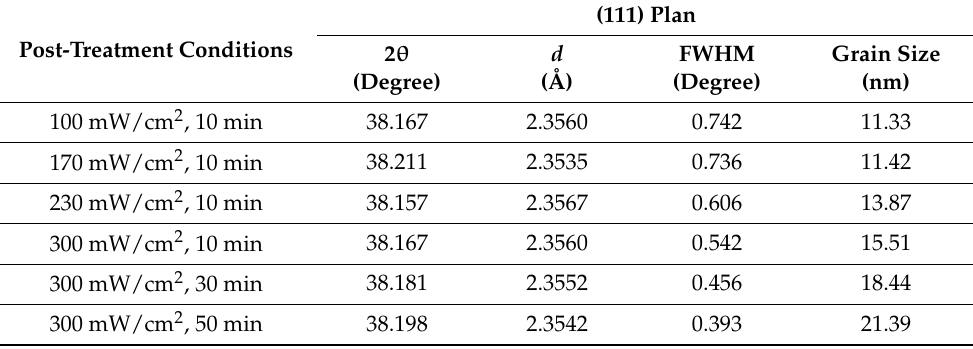
Figure 13. XRD patterns of Ag thin films photo-sintered at different light intensities: PET substrate ( a ), as-deposited film ( b ), 100 mW/cm 2 ( c ), 170 mW/cm 2 ( d ), 230 mW/cm 2 ( e ), and 300 mW/cm 2 ( f ), respectively. The wavelength of UV-LED module was 365 nm, and all samples were photo-sintered for 10 min. Table 3. Grain size of Ag thin films photo-sintered at various light intensities and for different irradiation durations. The wavelength of UV-LED module was 365